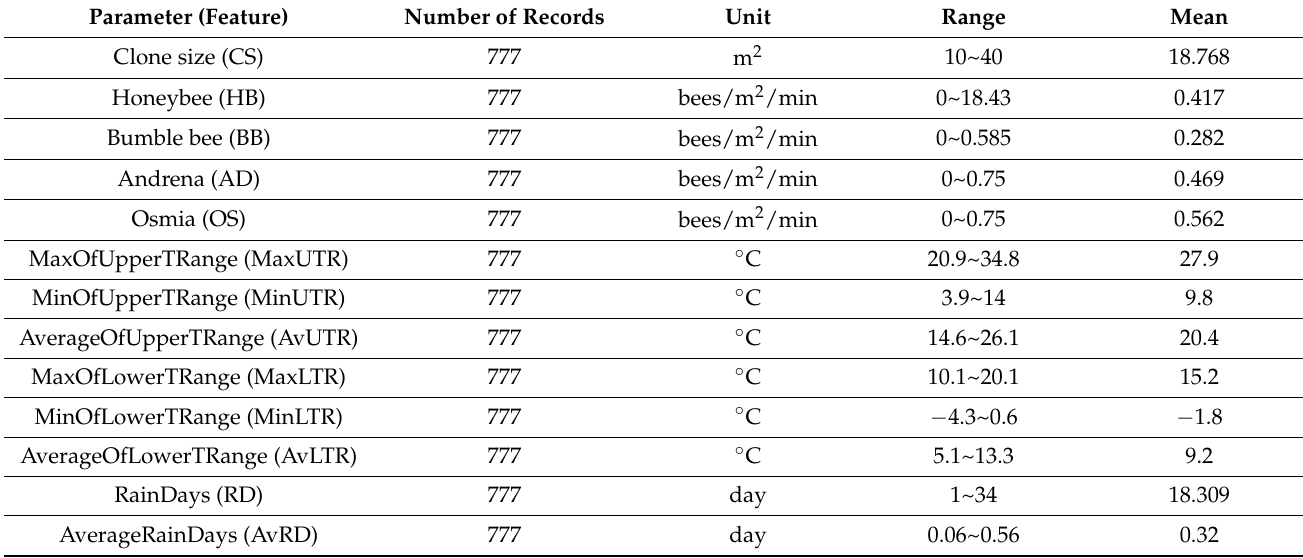
Table 1. Summary of simulated wild blueberry fruit-set data